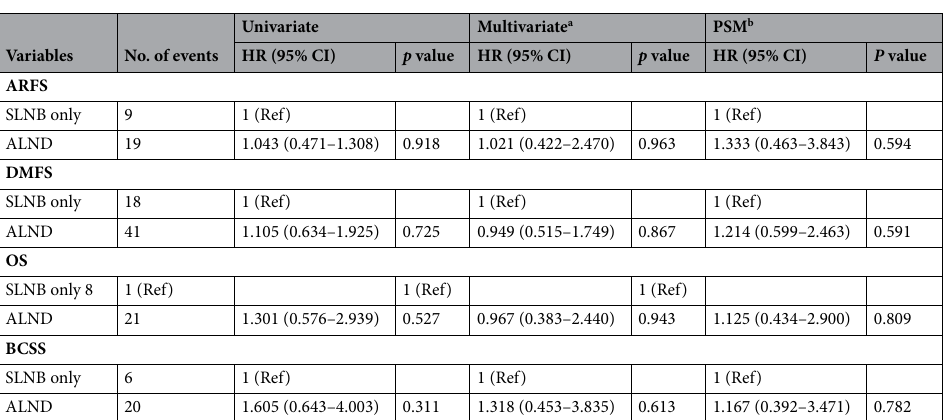
Figure 1. Before matching, Unadjusted Kaplan–Meier survival analysis of ( A ) axillary recurrence-free survival (ARFS), ( B ) distant metastasis-free survival (DMFS), ( C ) overall survival (OS), and ( D ) breast cancer-specific survival (BCSS) between the sentinel lymph node biopsy (SLNB) only and axillary lymph node dissection (ALND) groups.